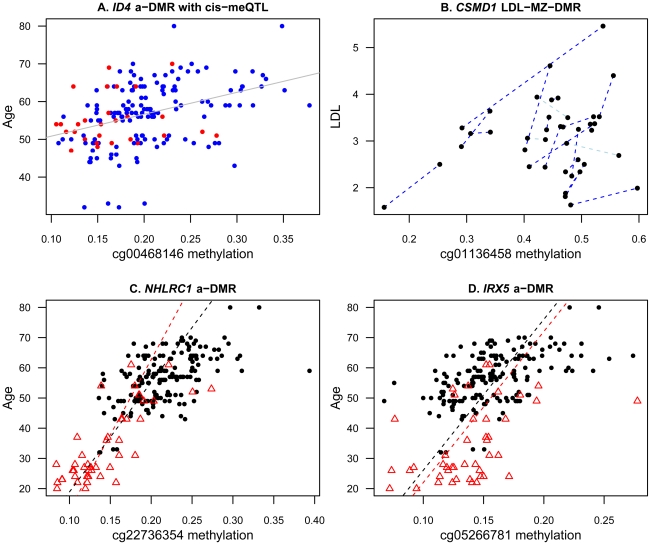
Examples of age and age-related phenotype DMRs in the discovery and replication samples.(A) Example of an a-DMR probe (cg00468146 in ID4), which also has cis-meQTLs. Individuals are coloured according to cis-meQTL rs12660828 genotype (AG = red, GG = blue). (B) MZ twin methylation difference analyses identify potential environmentally-triggered DMR cg01136458 in CSMD1 associated with LDL. MZ co-twins are linked by dark blue (positive DMR effect) or light blue (negative DMR effect) dashed lines. (C,D) The two most associated a-DMRs (in NHLRC1 (C) and IRX5 (D)) in the discovery sample of 172 individuals (black dots) also replicate in the sample of 44 younger individuals (red triangles). Dashed lines represent estimated effects within the discovery (black) and replication (red) sample.